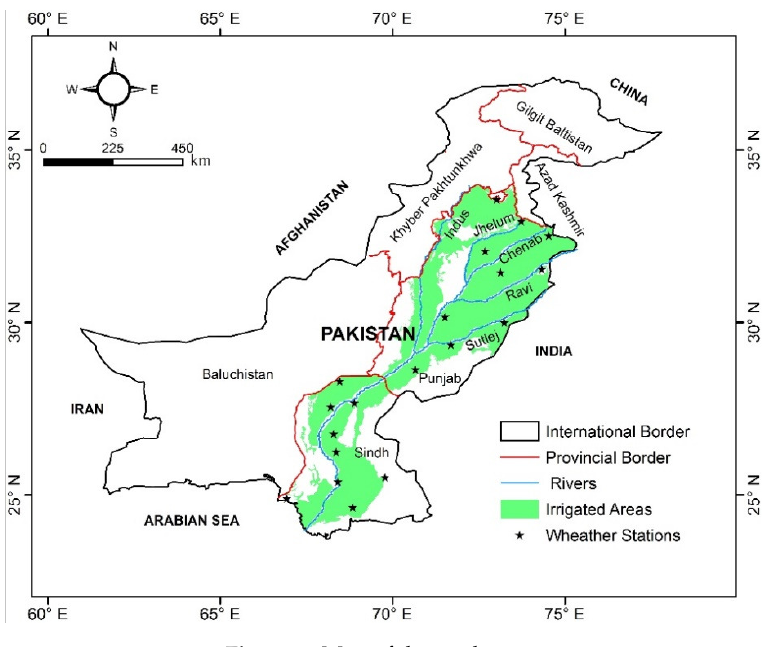
Figure 1. Map of the study area.